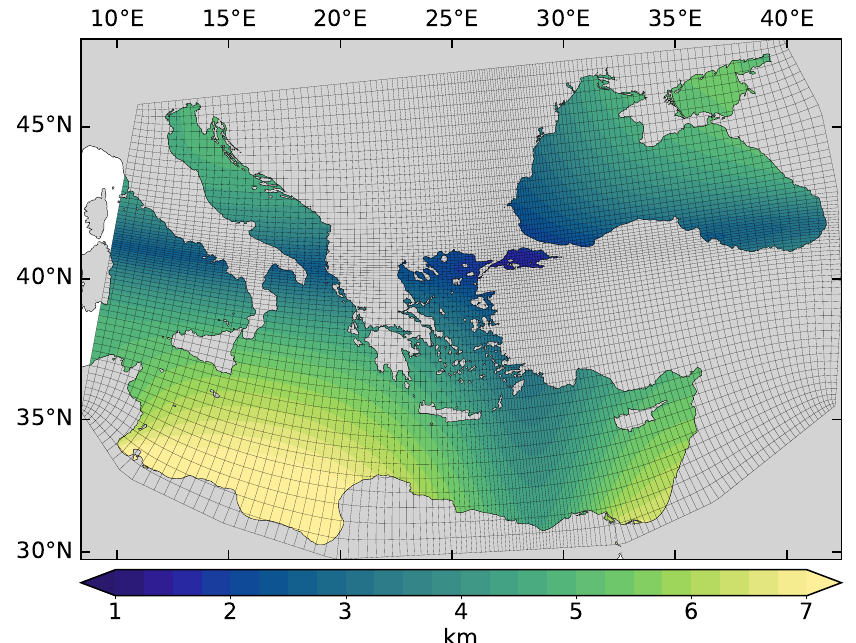
Figure 2. Grid geometry of the simulation. For clarity reasons in this figure, grid lines are drawn at eight times lower resolution (8 × ) compared to the final product. The equivalent square area grid size of the simulation is shown in color-scale. Final grid is composed of 512 × 1024 horizontal points, with 30 vertical sigma